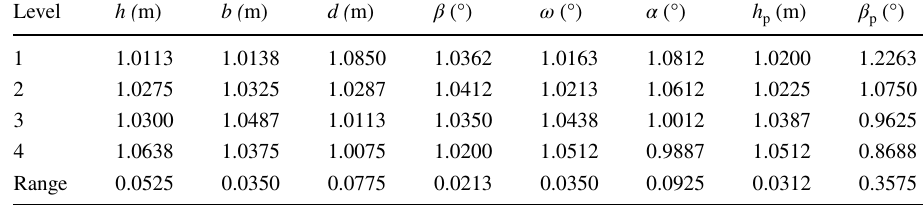
Table 3 Range analysis of orthogonal tests of inner dump